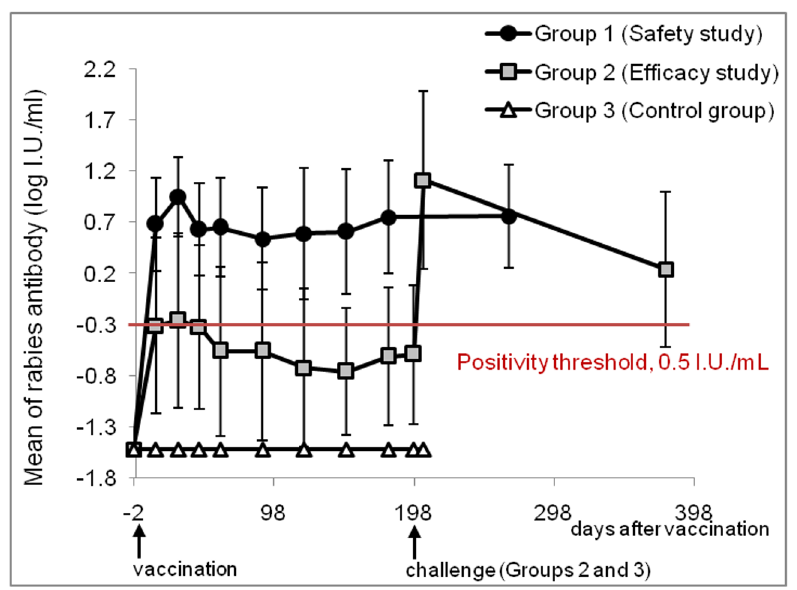
Fig 2. Rabies neutralising antibody (mean log IU/ml) kinetics of safety, efficacy,and control groups. On D0, the ferret badgersin Group 1 receiveda 10 9 /dose of SAG2, Group 2 receiveda 10 8 /dose of SAG2, and Group 3 receivedPBS (non-vaccinated).On D198, both Groups 2 and 3 were challenged with the Taiwan ferret badgerrabies virus. Serum sampleswere measuredwith the fluorescent antibody virus neutralisation (FAVN) test, and titres are expressedthrough international units per ml (IU/ml). The symbols (circle, square, and triangle)represent means and standarddeviations (SD).